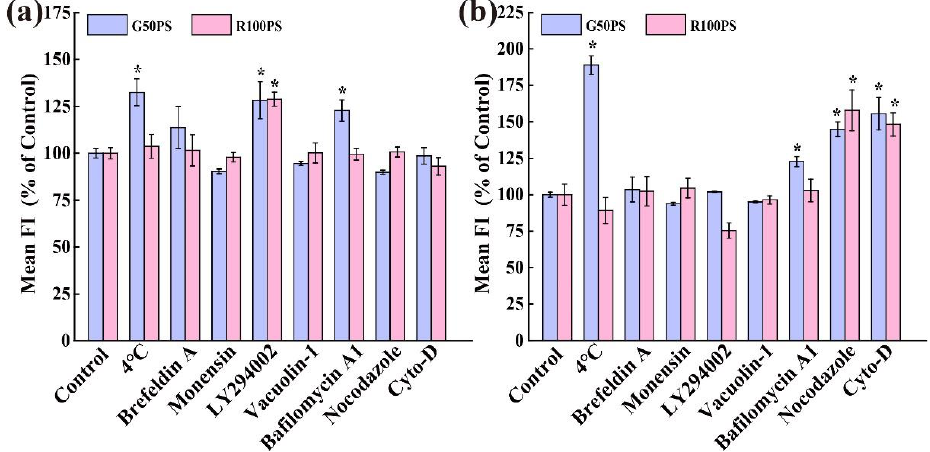
Figure 8. Exocytosis pathways of PS NPs in A549 cells ( a ) and BEAS-2B cells ( b ). Cells were incubated with 20 µ g/mL PS NPs for 4 h, and then the cells were cultured in fresh medium at 4 ◦ C or with/without exocytosis inhibitors for 2 h. The cells cultured in the fresh medium without exocytosis inhibitors were set as the control (100%). *P < 0.05 compared with the control (n = 3). Furthermore, using CLSM, we observed that some G50PS in A549 cells left the lyso- somes at 4 h (Figure 9a). However, no changes were observed in mitochondria (Figure 9b), possibly because of the low content of G50PS in mitochondria. The content of R100PS in both lysosomes and mitochondria did not change significantly (Figure 9c,d). Differ-